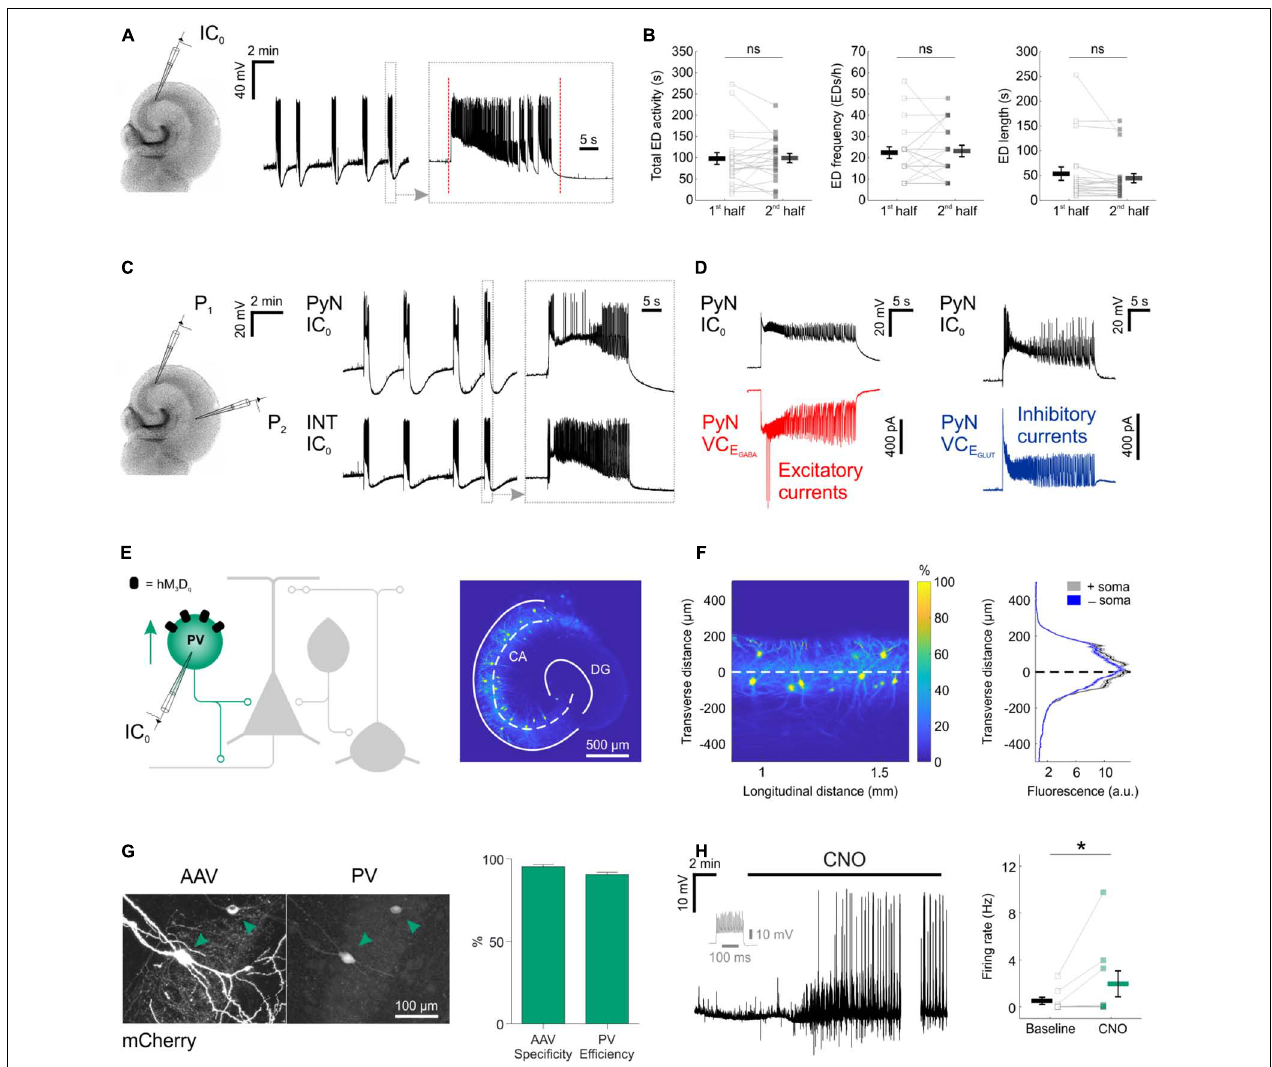
FIGURE 1 | Chemogenetic recruitment of hippocampal interneurons in an in vitro model of epileptiform activity. (A) Current-clamp recording of a CA3 pyramidal neuron from a mouse organotypic hippocampal slice reveals repeated EDs. The vertical red dotted lines in the expanded trace mark the onset and the termination of the underlying ED, as determined by an automated detection algorithm. (B) A 15-min time window was used to assess the stability of the epileptiform activity. Total ED activity, defined as the cumulative duration of ED activity [left, 96.8 ± 13.9 s during 1st half, 97.9 ± 10.9 s during 2nd half; N = 22 slices, W ( 21 ) = 110.5, p = 0.8715, two-tailed Wilcoxon signed-rank test], ED frequency [middle, 22.2 ± 2.7 EDs/h during 1st half, 22.9 ± 2.7 EDs/h during 2nd half; N = 22 slices, W ( 12 ) = 34, p = 0.7153, two-tailed Wilcoxon signed-rank test], and individual ED length [right, 52.8 ± 13.4 s during 1st half, 43.9 ± 9.2 s during 2nd half; N = 22 slices, W ( 21 ) = 71, p = 0.1281, two-tailed Wilcoxon signed-rank test] were stable across the 15-min time window. (C) A dual current-clamp (IC 0 ) electrophysiological recording of a CA3 pyramidal neuron (PyN) and a GABAergic interneuron (INT) reveal spontaneous EDs in a mouse organotypic hippocampal brain slice (left). Expanded traces (right) show that both excitatory and inhibitory neurons are recruited during the EDs. (D) Simultaneous current clamp and voltage clamp (VC) recordings from pairs of pyramidal neurons demonstrate that strong barrages of excitatory (bottom-left, red) and inhibitory (bottom-right, blue) post-synaptic currents occur throughout the EDs, as monitored by current clamp recordings from a neighboring pyramidal neuron (top). E GABA , reversal potential for GABAergic current; E GLUT , reversal potential for glutamatergic current. (E) Cartoon of hippocampal circuitry (left) showing the targeting of the hM 3 D q receptor to PV interneurons. Confocal image (right) of a hippocampal slice from a PV-cre mouse illustrates the fluorescence distribution profile of virally transduced PV interneurons. The superimposed white dashed line marks the center of the pyramidal cell layer. Continuous white lines indicate the dentate gyrus (DG) and outline of the CA areas (CA). (F) The confocal image was linearized (left) to facilitate the quantification of the transverse expression profile for PV interneurons, relative to the pyramidal cell layer (dashed line at zero). This confirmed that PV interneurons ( + soma) and their processes ( − soma) were restricted to the pyramidal cell layer (right). (G) The immunohistochemical characterization of PV interneurons transduced with AAV 8 -hSyn-DIO-hM 3 D q -mCherry demonstrates high targeting specificity and efficiency ( N = 14 sections from six slices). (H) An example current-clamp recording of a PV interneuron expressing hM 3 D q receptors shows that CNO promotes action potential firing (left). The firing pattern of the neuron in response to a 500 pA square wave current pulse is shown in gray. The break in the recording reflects a period during which the intrinsic properties of the neuron were monitored. Recordings were conducted in kynurenic acid to isolate the direct effects of hM 3 D q receptor activation, and to prevent the occurrence of EDs. Population data shows a significant increase in firing rate following CNO [right; N = 9 slices, W ( 7 ) = 0, p = 0.0156, two-tailed Wilcoxon signed-rank test]. ∗ p <